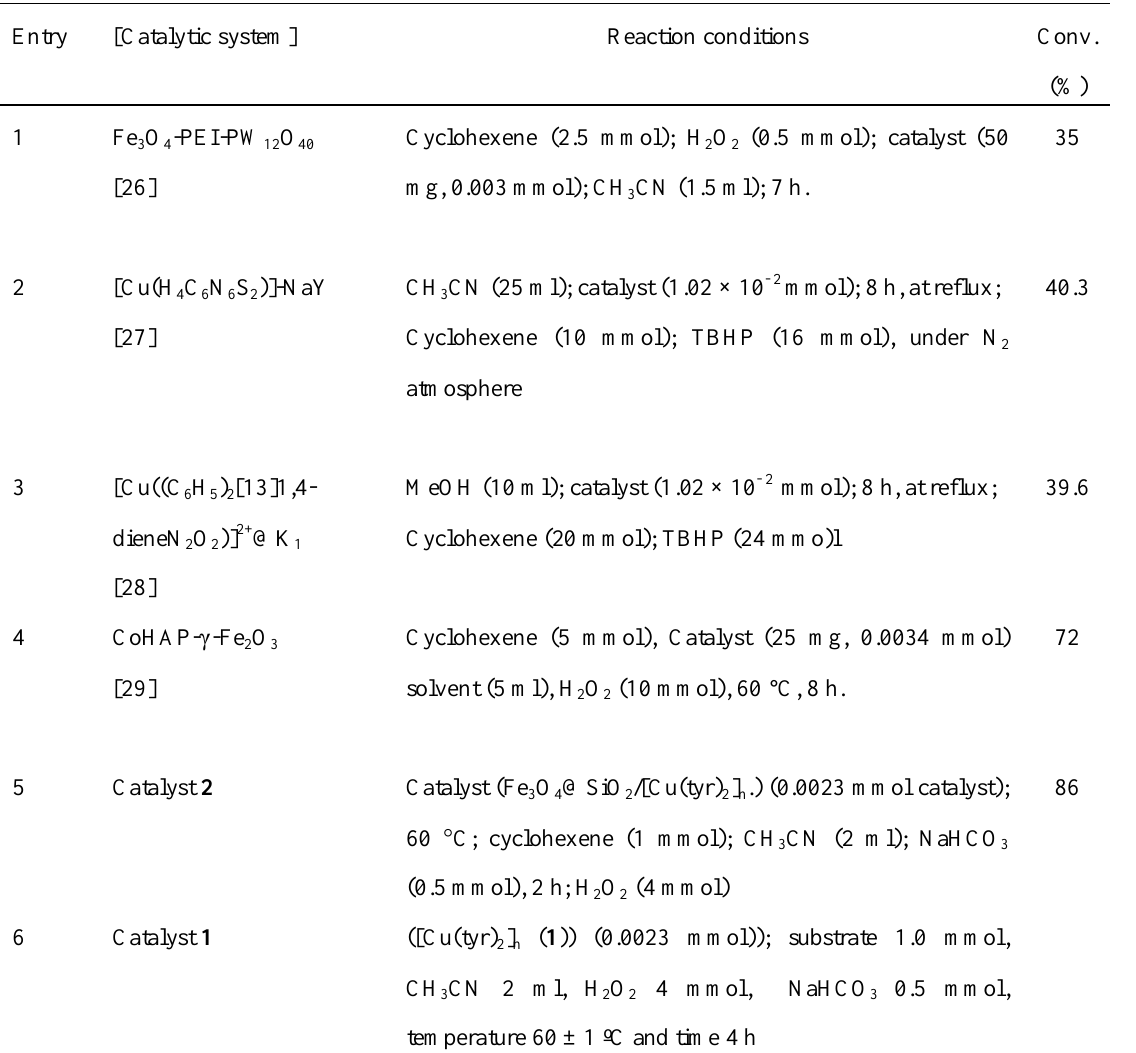
Table 3. Comparison of Literature Catalysts and our Catalyst System for Oxidation of Cyclohexene Entry [Catalytic system] Reaction conditions Conv.